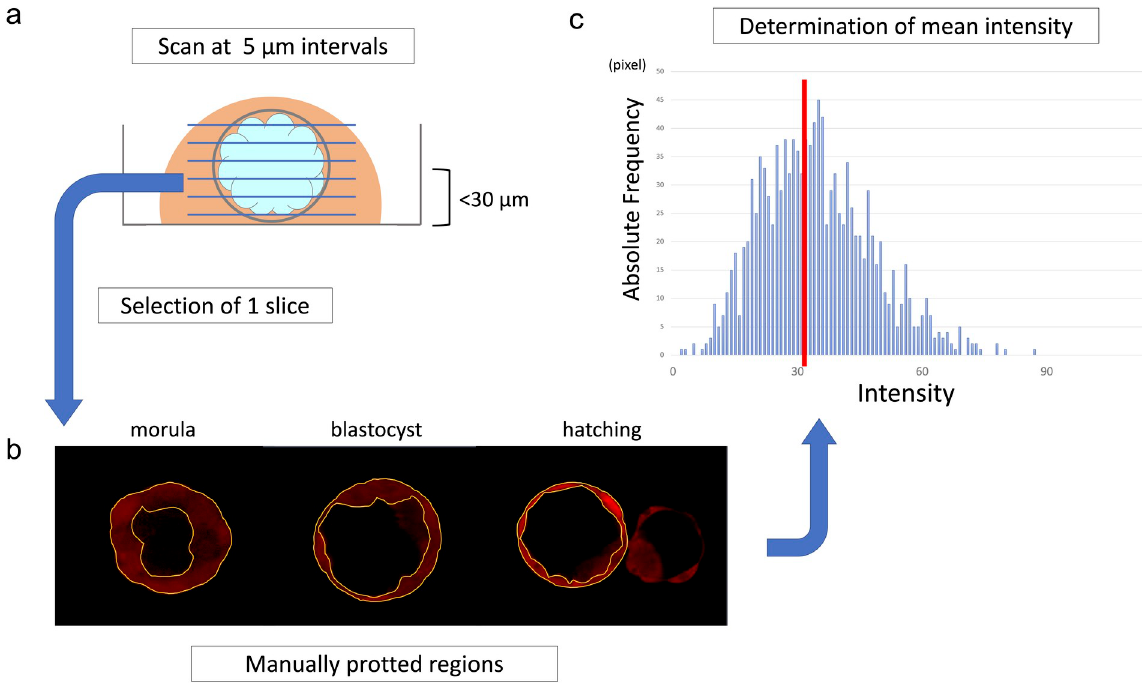
Fig 3. Intensity measurement procedure. (a) The image was taken at a slice thickness of 5 μ m, and the optimum slice was selected within a range of 30 μ m from the bottom. (b) The circumference of the target cells or the blastocoel was manually plotted to determine the measurement region. (c) The ZEN Software measured the intensity on a pixel-by-pixel basis and automatically calculated the mean intensity. 33342 (1:1000) for 20 min at room temperature. After washing three times in wash buffer, the